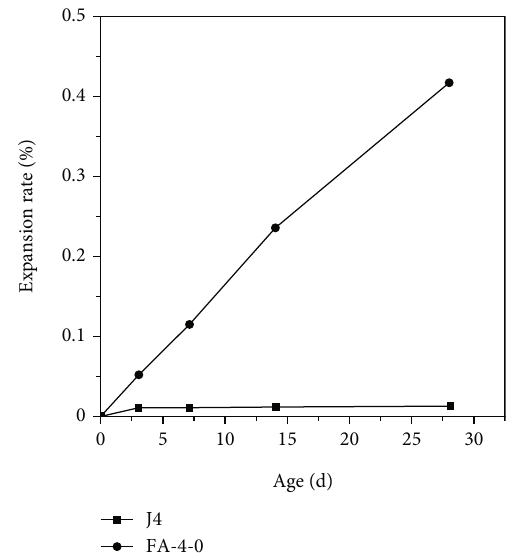
Figure 7: The diagram between FA-4-0 benchmark specimen and age.